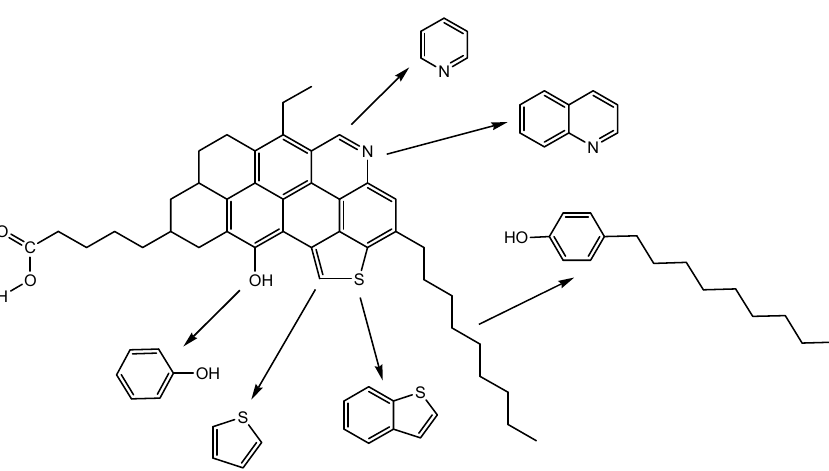
Figure 9. Selection of model compounds.